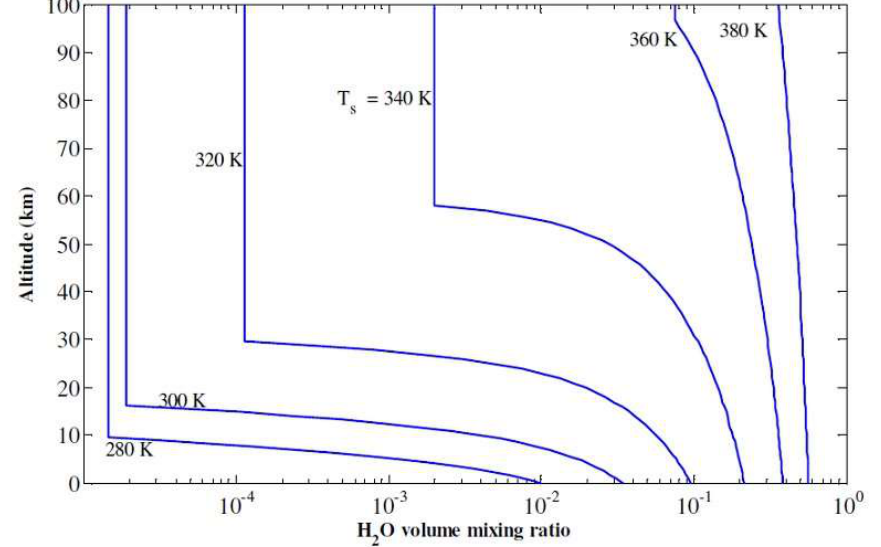
Figure 1. Vertical water vapor (volume) mixing ratio profiles for the Earth at different mean surface temperatures. An abrupt increase in the water vapor mixing ratio occurs at ~340 K, after which point the water vapor surface mixing ratio is ~20% [21] and the moist greenhouse is triggered (adapted from Ramirez [22]). The cold trap is often coincident with the tropopause, which separates the upper atmosphere from the convective region, “trapping” water vapor to lower atmospheric levels (i.e., below the tropopause).